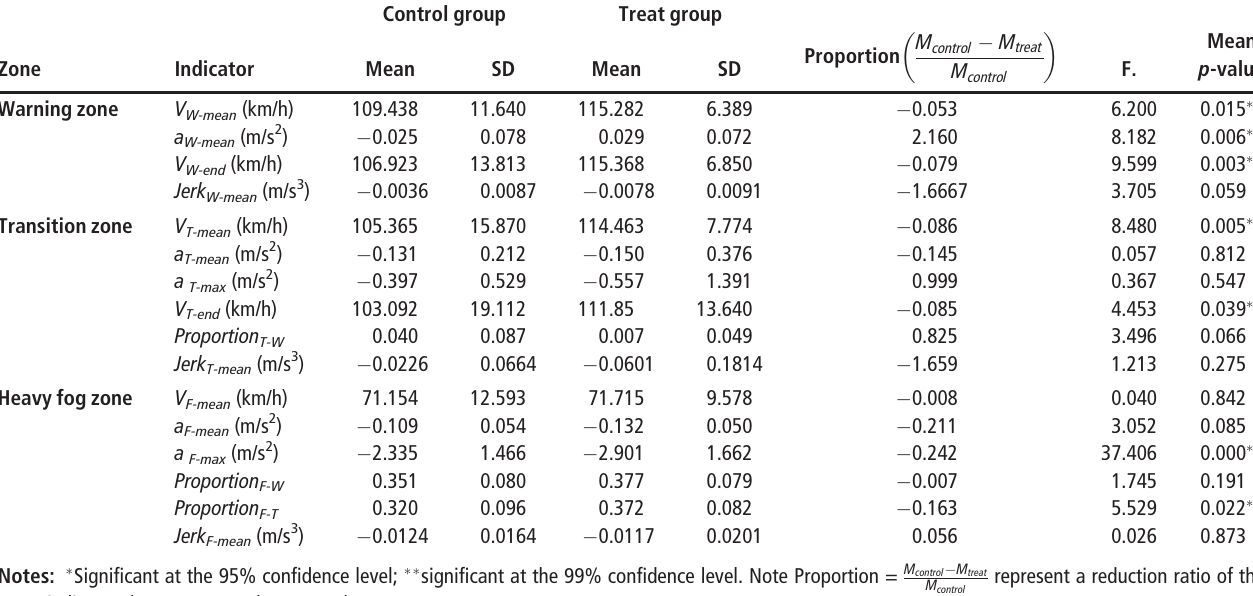
mean indicators between control group and treat group